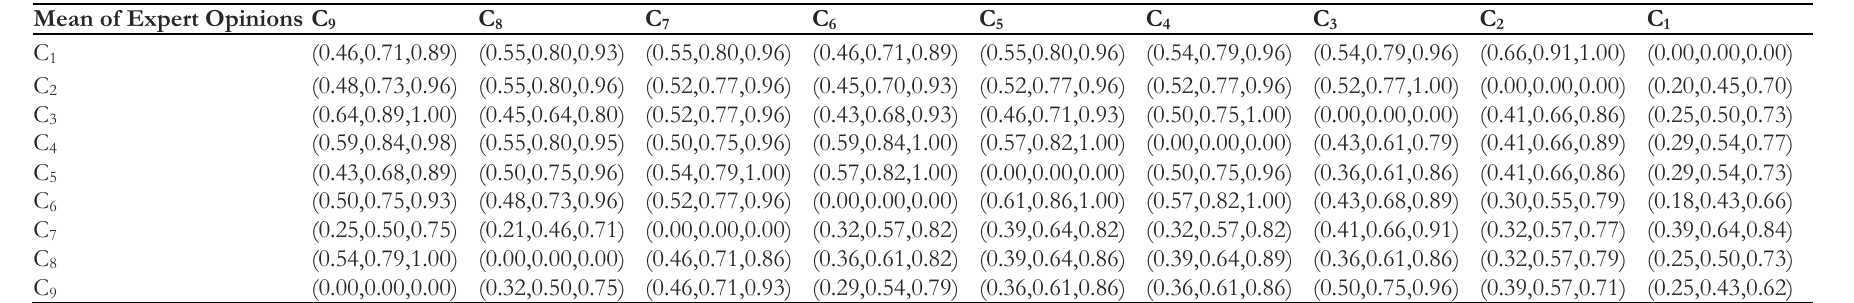
Table 4. The total mean of the expert opinions.